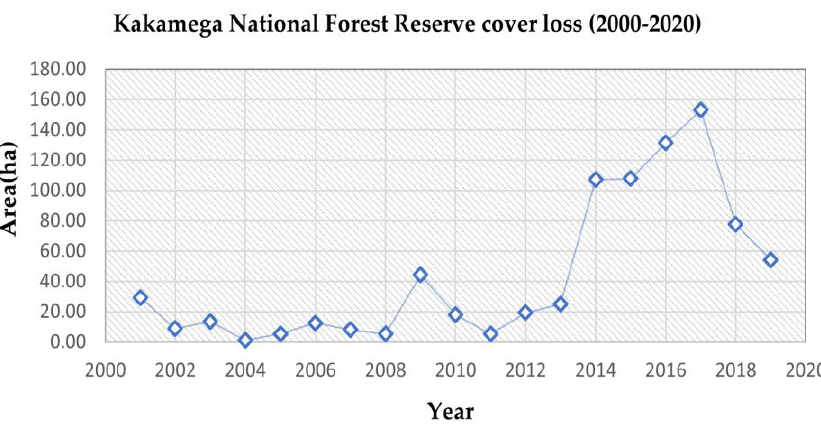
Figure 4. Trend of forest cover loss using Hansen Global Forest Change 2000–2020. Figure 4 . Trend of forest cover loss using Hansen Global Forest Change 2000 – 2020.